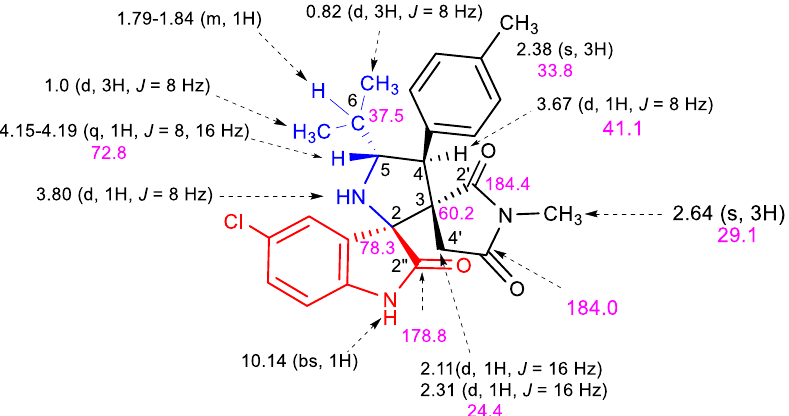
Figure 2. 1 H (black) chemical shifts with coupling constants and 13 C NMR (pink) data (ppm) of 5b .